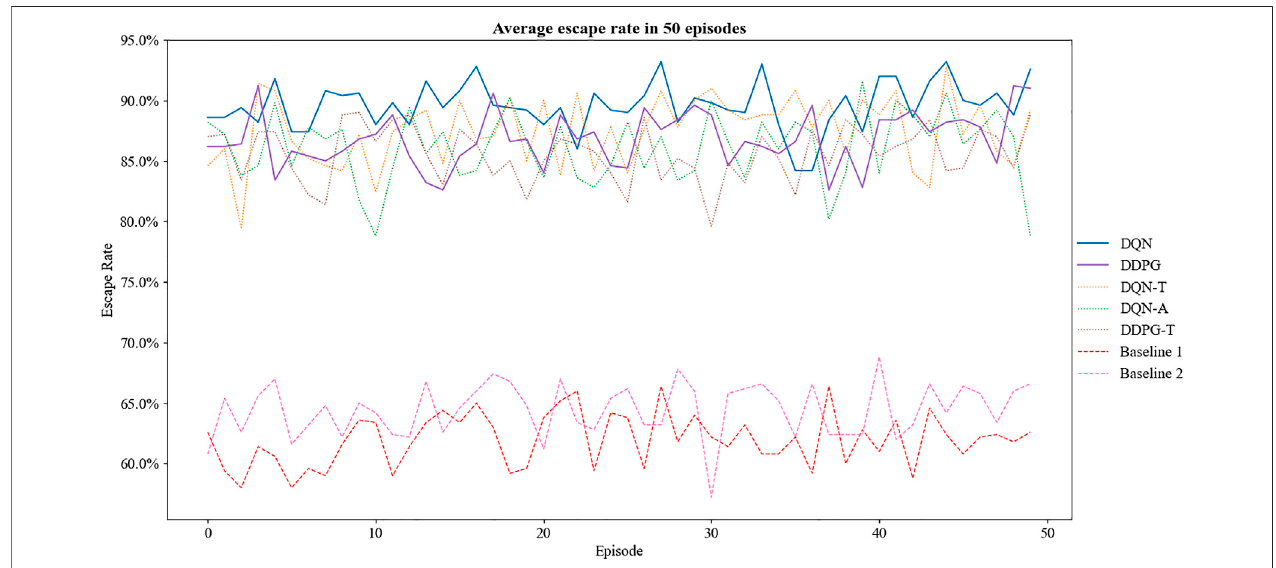
FIGURE 6 | Average escape rate in 50 episodes.